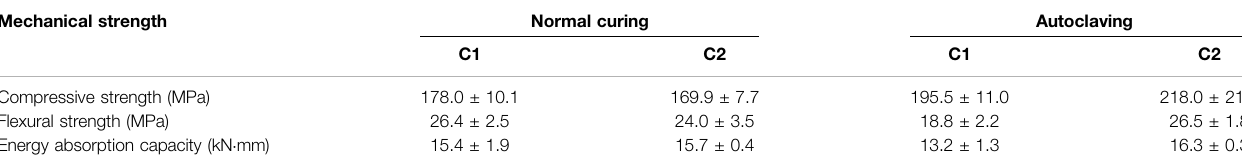
TABLE 3 | Mechanical properties of the samples after different treatments. Mechanical